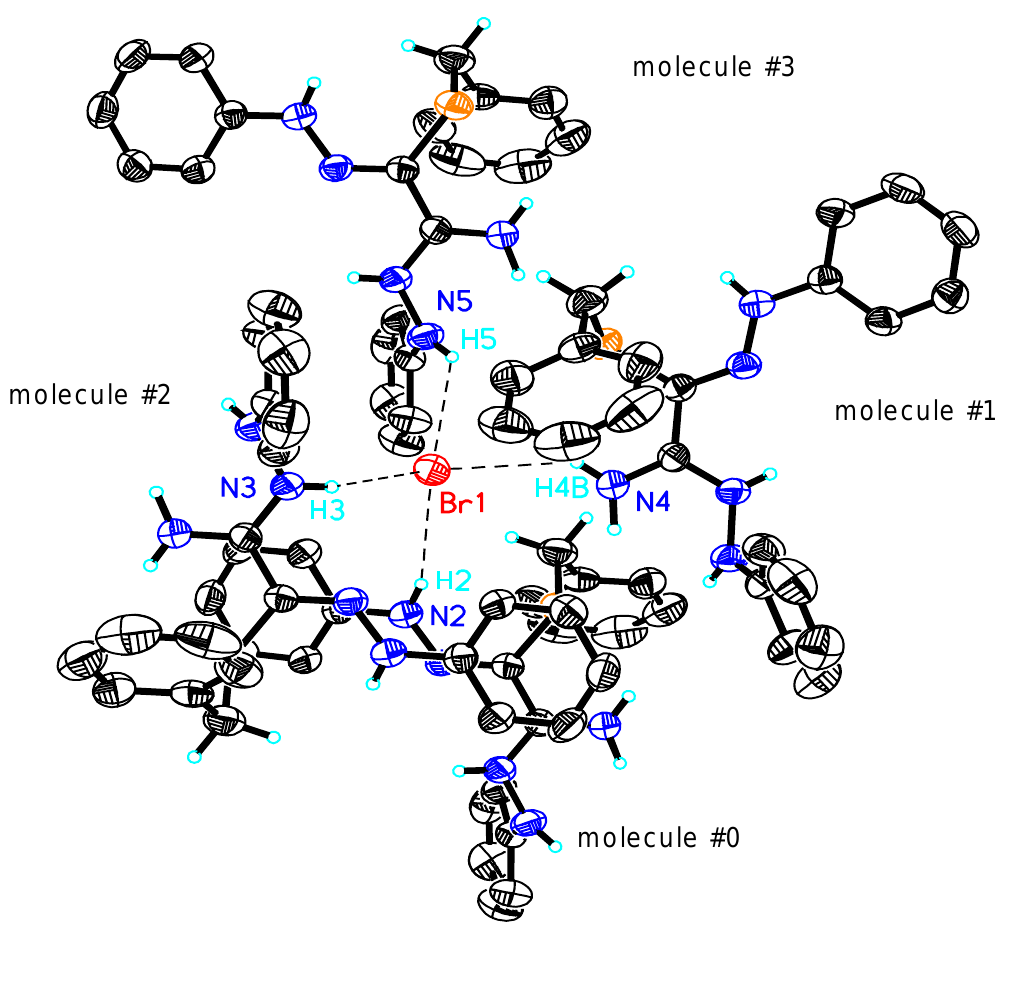
Figure 2. Arrangement of molecules of 4d in the crystal lattice (aromatic hydrogens omitted for